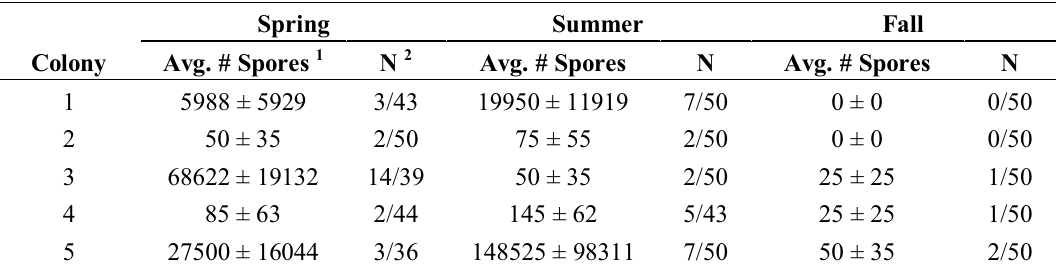
Table 2. Spore analysis for colonies over three seasons in